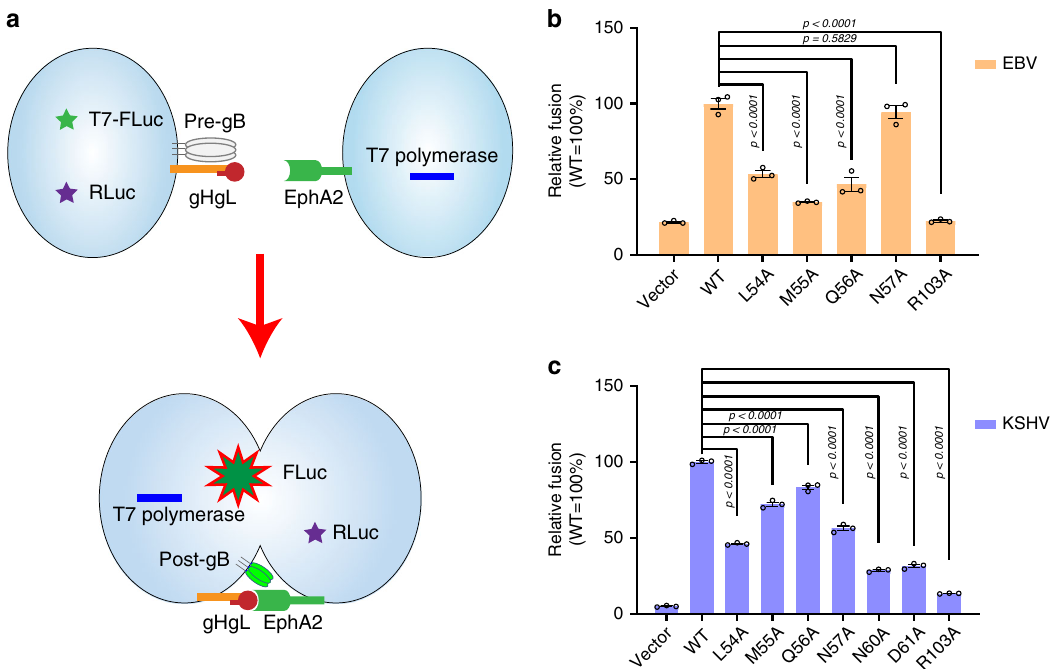
Fig. 4 Key residues in the gHgL-binding site of EphA2 are critical for cell fusion. a Schematic diagram of the cell-based fusion assay. The cells expressing gB, gH, gL, and fi re fl y luciferase reporter gene under the control of the T7 promoter were co-cultured with other cells expressing T7 polymerase and EphA2 proteins. Receptor EphA2 bound to gHgL, increasing the fusion of the two types of cells. T7 polymerase initiated the expression of fi re fl y luciferase, which was detected using the Dual-Luciferase ® Reporter Assay System. Renilla luciferase was used as a transfection control. Pre-gB indicates the pre-fusion state of gB, whereas post-gB indicates the post-fusion state of gB. b , c Cell-based EBV ( b ) and KSHV ( c ) fusion assays were performed by co-culturing of HEK- 293T cells transfected with plasmids expressing EphA2 and mutants, and HEK-293T cells transfected with plasmids expressing gB and EBV gHgL ( b ) or KSHV gHgL ( c ). Representative results from three experiments are shown. Relative fusion was normalized to that of wild type EphA2. The data are presented as mean ± SEM ( n = 3 independent replicates). Statistical signi fi cance was analyzed using Ordinary one-way ANOVA with Dunnett ’ s multiple comparison test for multiple groups. The GenBank accession codes for gH, gL, and gB are shown in the Supplementary Table 3. Source data are provided as a Source Data fi